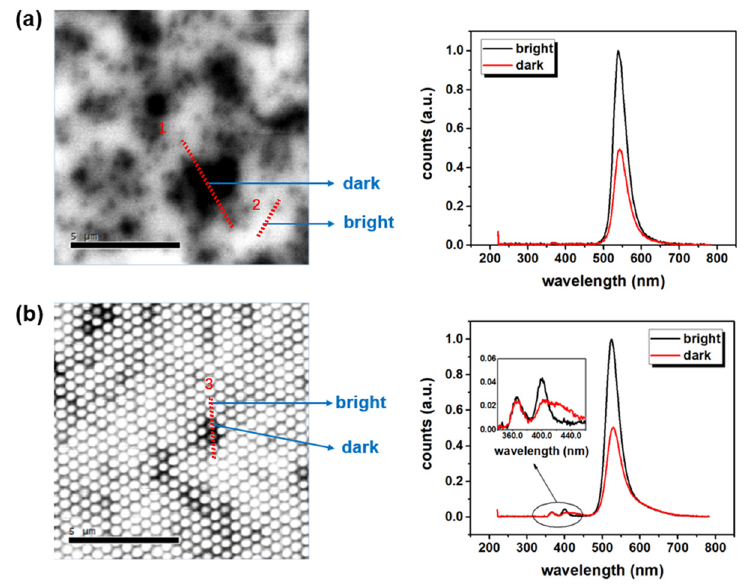
Figure 2. ( a ) Panchromatic CL image of conventional LED and two spectra at marked bright and dark regions; ( b ) CL panchromatic image of nanorod array LED and two spectra at marked bright and dark regions. The inset shows the magnified CL spectra in the range of 350–450 nm.